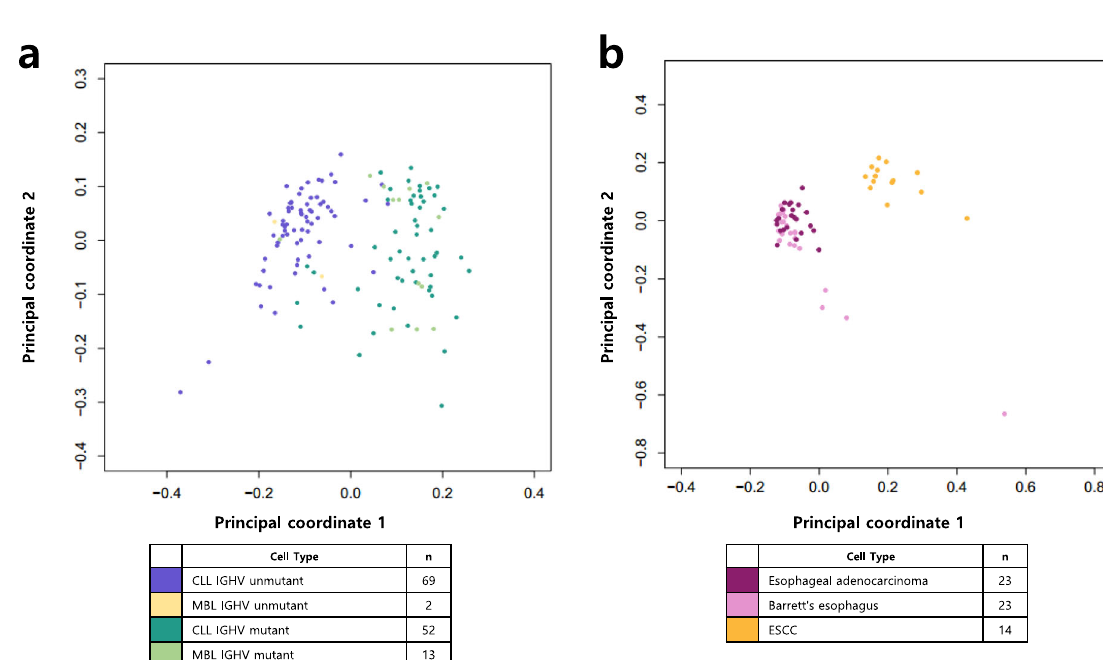
Fig. 1 Principal coordinate analysis (PCOA) of individual cancer samples. a MBL and CLL with different IGHV mutation status. b Barrett ’ s esophagus, esophageal adenocarcinoma, and